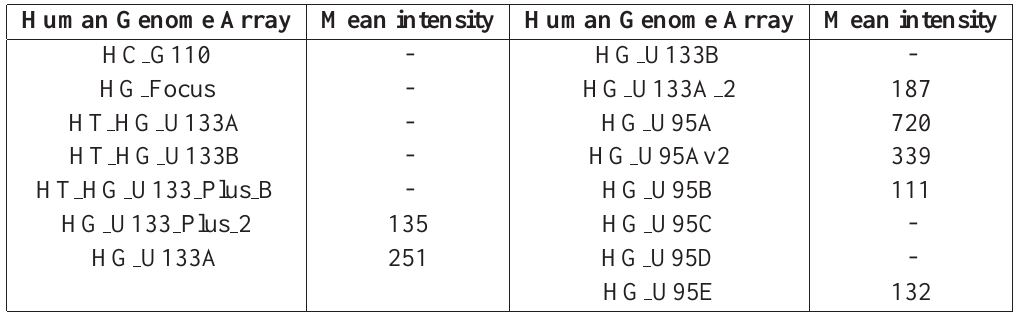
Table 1: Affymetrix Human GeneChips used in the probe mapping. The mean probe intensity of all probes over all cel files is shown for the arrays with unique probe